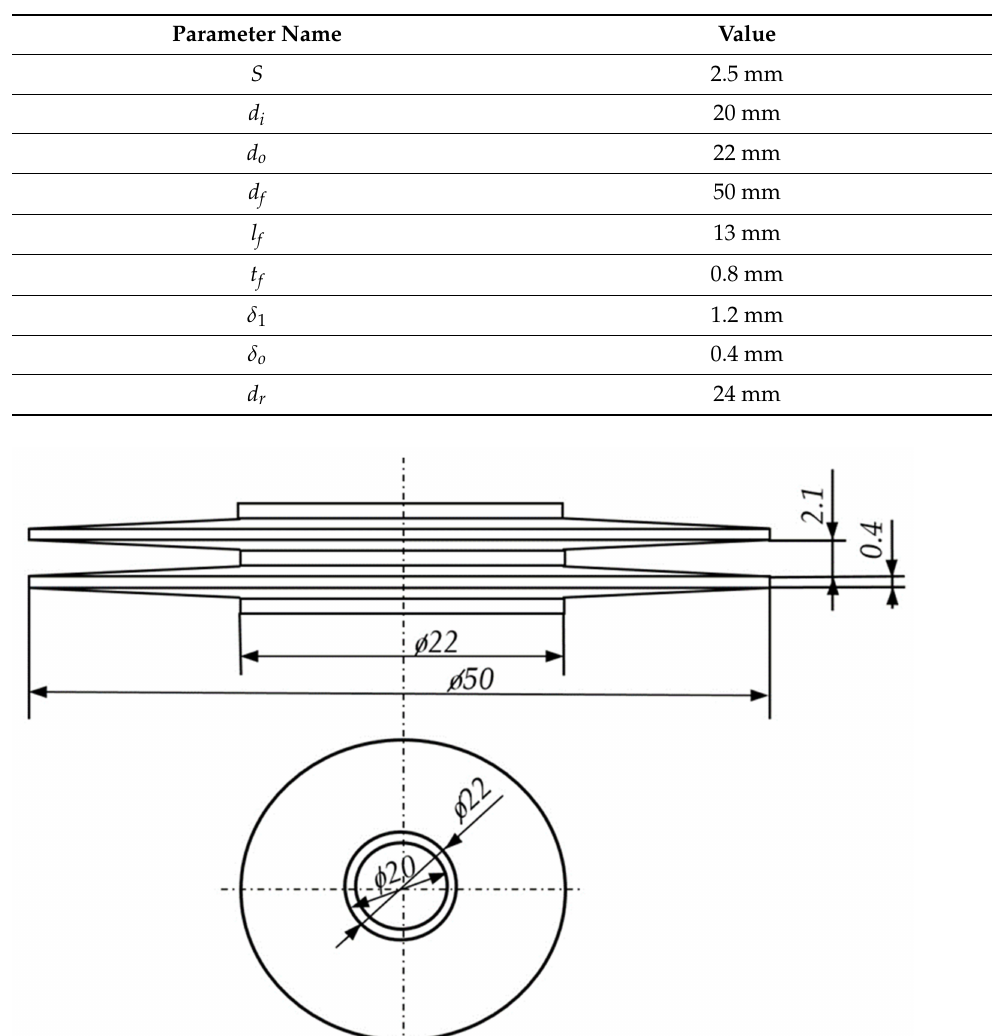
Table 2. Geometrical parameters for the high-finned tube.